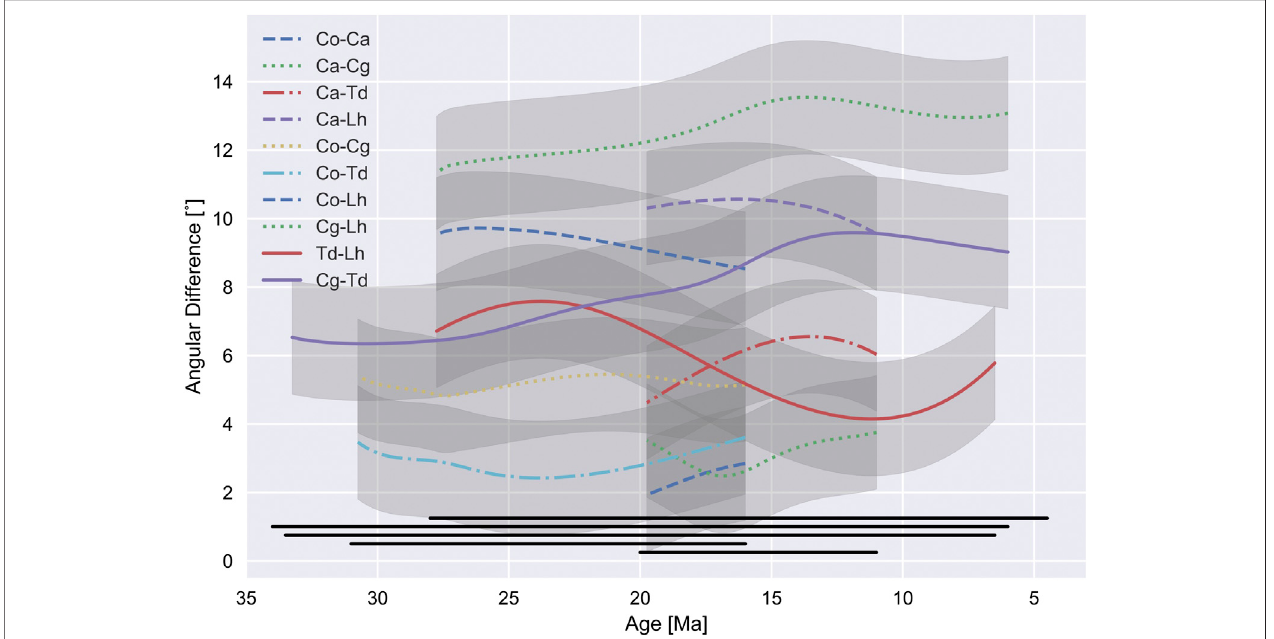
FIGURE 7 | Angular difference between hotspot track pairs with respect to time, showing relative motion between eastern Australian hotspots. Gray regions indicate 95% con fi dence limits. Black horizontal lines indicate range of ages over which each hotspot is active (from bottom to top: Ca, Canobolas; Co, Comboyne; Td, Tasmantid; Cg, Cosgrove; Lh, Lord